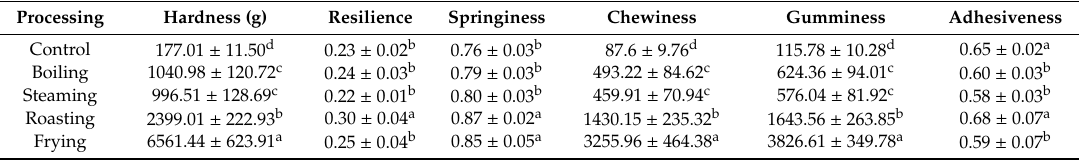
Table 3. Influences of di ff erent cooking methods on texture profile of Spanish mackerel